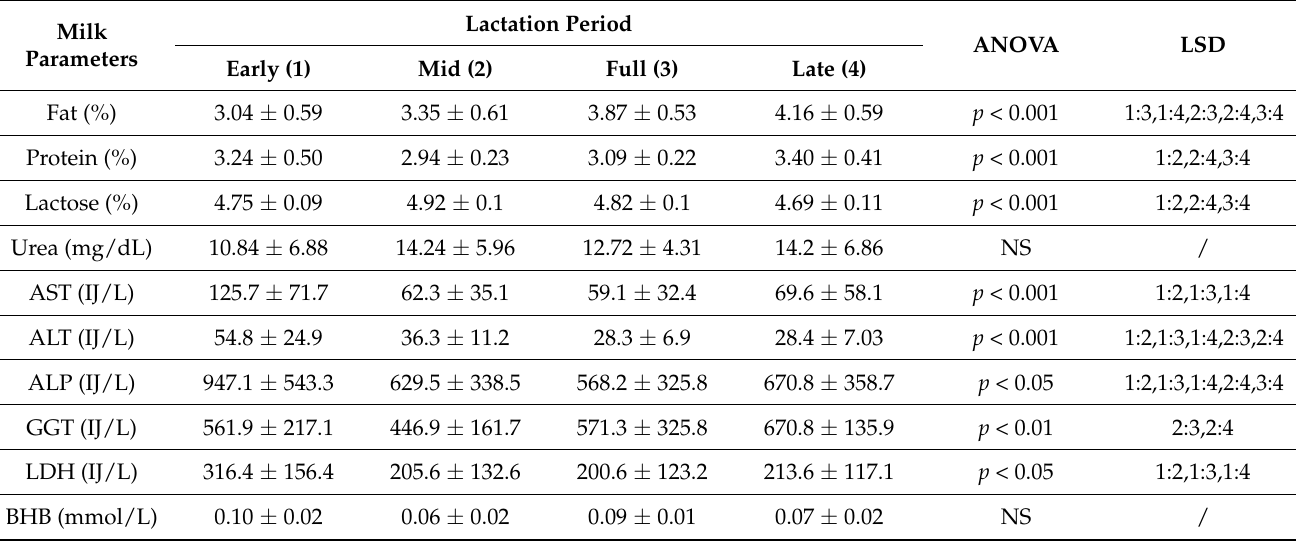
Table 2. Milk metabolic parameters in early (Group 1), mid (Group 2), full (Group 3) and late (Group 4) lactation dairy